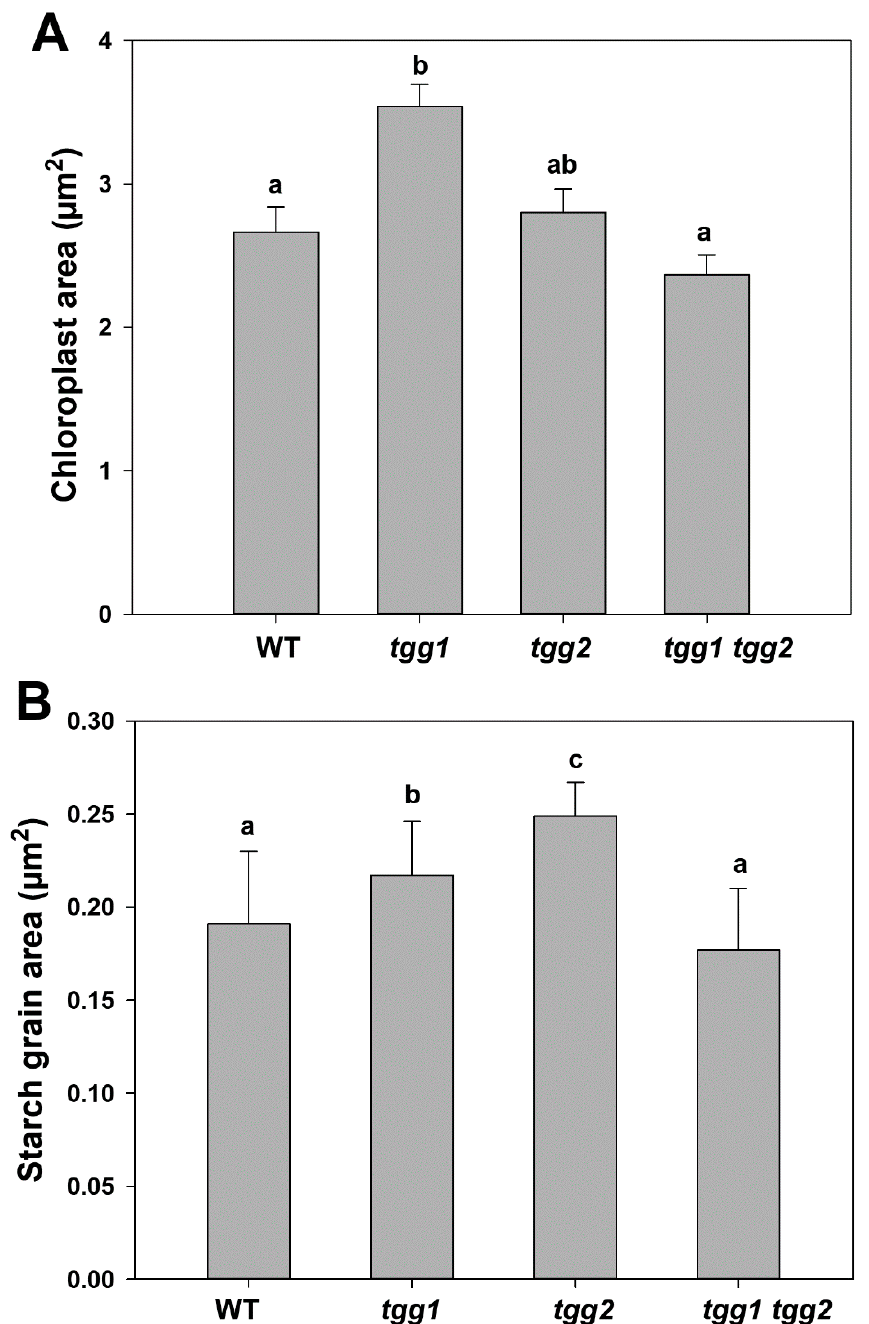
Figure 7. Chloroplast and starch grain area of guard cells from transmission electron micrographs of rosette leaves of WT, tgg1 , tgg2 single, and tgg1 tgg2 double mutants of Arabidopsis . ( A ). Area of guard cell chloroplast in WT, tgg single and double mutants. Bars represent the means ± SE (WT: n = 49), ( tgg1: n = 59), ( tgg2: n = 35), and tgg1 tgg2 ( n = 41). Different letters (a and b) above the bars indicate significant differences in guard cell chloroplast area between WT, tgg1 , tgg2 , and tgg1 tgg2 as determined by a Kruskal-Wallis test followed by a Dunn’s method for pairwise comparisons ( p < 0.05). ( B ). Area of guard cell starch grains in WT, tgg single and double mutants. Bars represent the means ± SE (WT: n = 105), ( tgg1: n = 159), ( tgg2: n = 90), and tgg1 tgg2 ( n = 112). Different letters (a, b and c) above the bars indicate significant differences in guard cell starch grain area between WT, tgg1 , tgg2 , and tgg1 tgg2 as determined by a Kruskal-Wallis test followed by a Dunn’s method for pairwise comparisons ( p < 0.05).